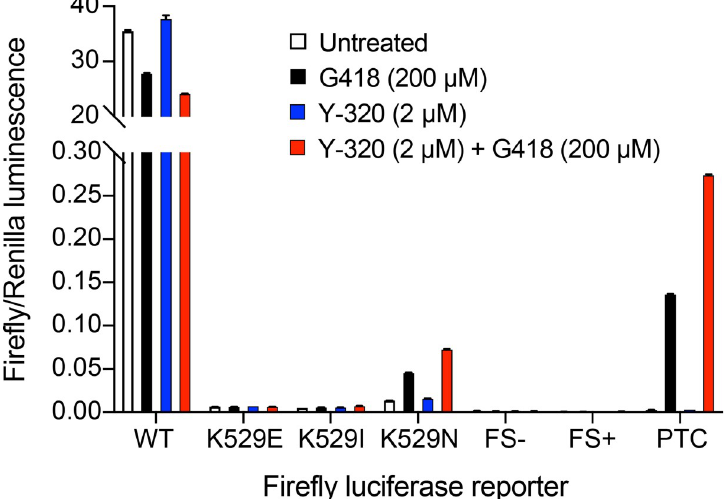
Fig 6. Effect of Y-320 on translation. H1299 cells transfected with WT Renilla and WT or mutated firefly luciferase plasmids were treated with the indicated compounds for 48 h. After cell lysis, mutated firefly luminescence was measured and normalized to that of Renilla luciferase (mean ± SD; n = 3). The positive control (WT-Luc) ratio was several orders of magnitude higher and was cropped on the graph. The mutant reporters K529E, K529I, and K529N measured misincorporation into the first, second, and third codon positions, respectively. The mutant FS+ contained a positive frameshift mutation by nucleotide insertion at position 81, whereas FS − mutant contained a negative frameshift mutation by nucleotide deletion at position 81. The PTC reporter contained a premature stop codon at amino acid 81. The numerical data underlying the plot can be found in S4 Data. FS, frameshift; PTC, premature termination codon; WT-Luc, wild-type